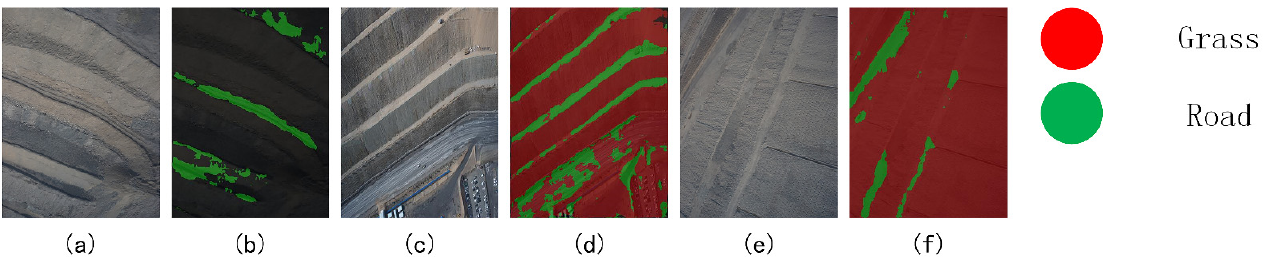
Figure 13. Demonstration of the effect of the algorithm proposed in the paper on various types of grass, ( a ) pictures of mining areas with less grassland, ( b ) the effect of the algorithm proposed in the paper on ( a , c ) pictures of moderate grassland mining areas, ( d ) the effect of the algorithm proposed in the paper on ( c , e ) pictures of mining areas with more grassland, ( f ) the effect of the alforithm proposed in the paper on ( e ). Table 7. Accuracy